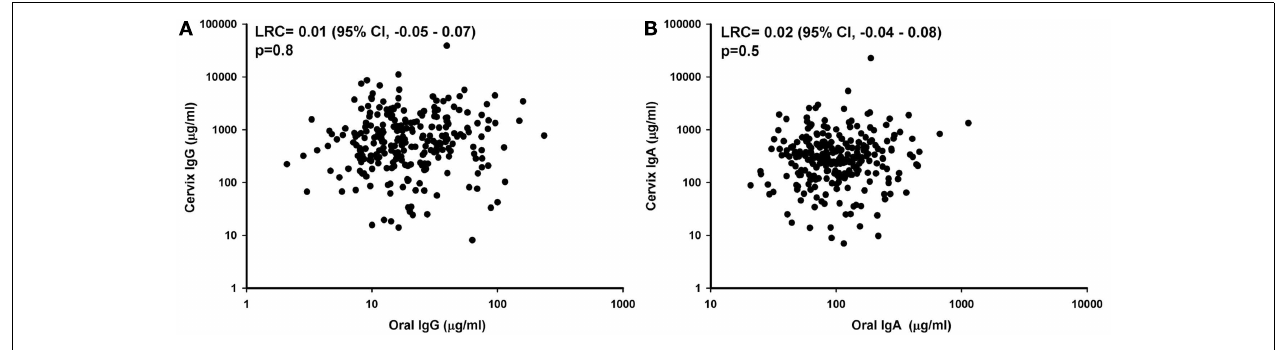
and IgA (B) levels are plotted based on untransformed values and include the three phases of the menstrual cycle from each participant. A p -value < 0.05 was considered significant, and LRC stands for Linear Regression